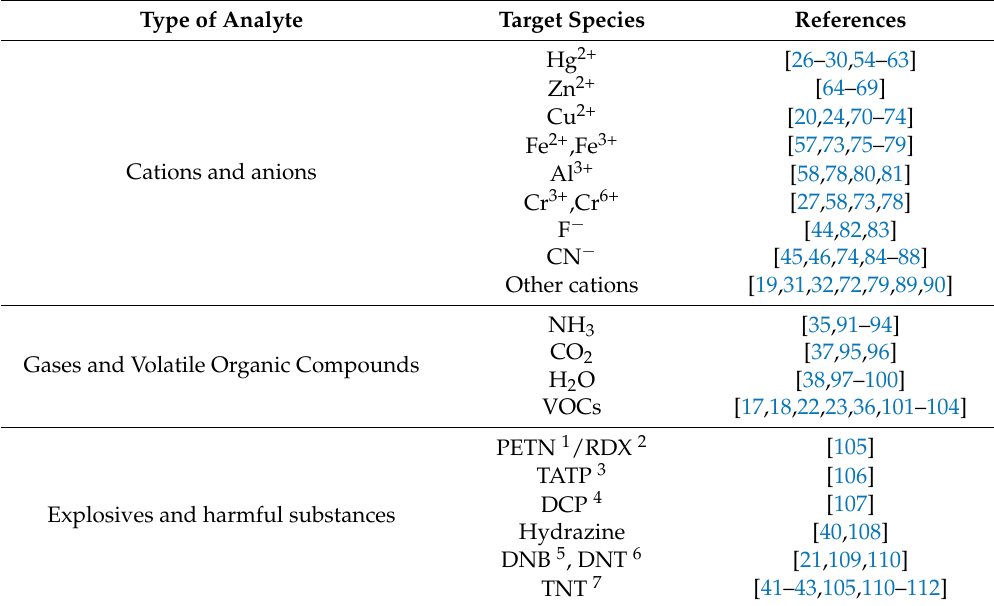
Table 1. Detection of analytes using sensory polymers. (For additional information, please see reference